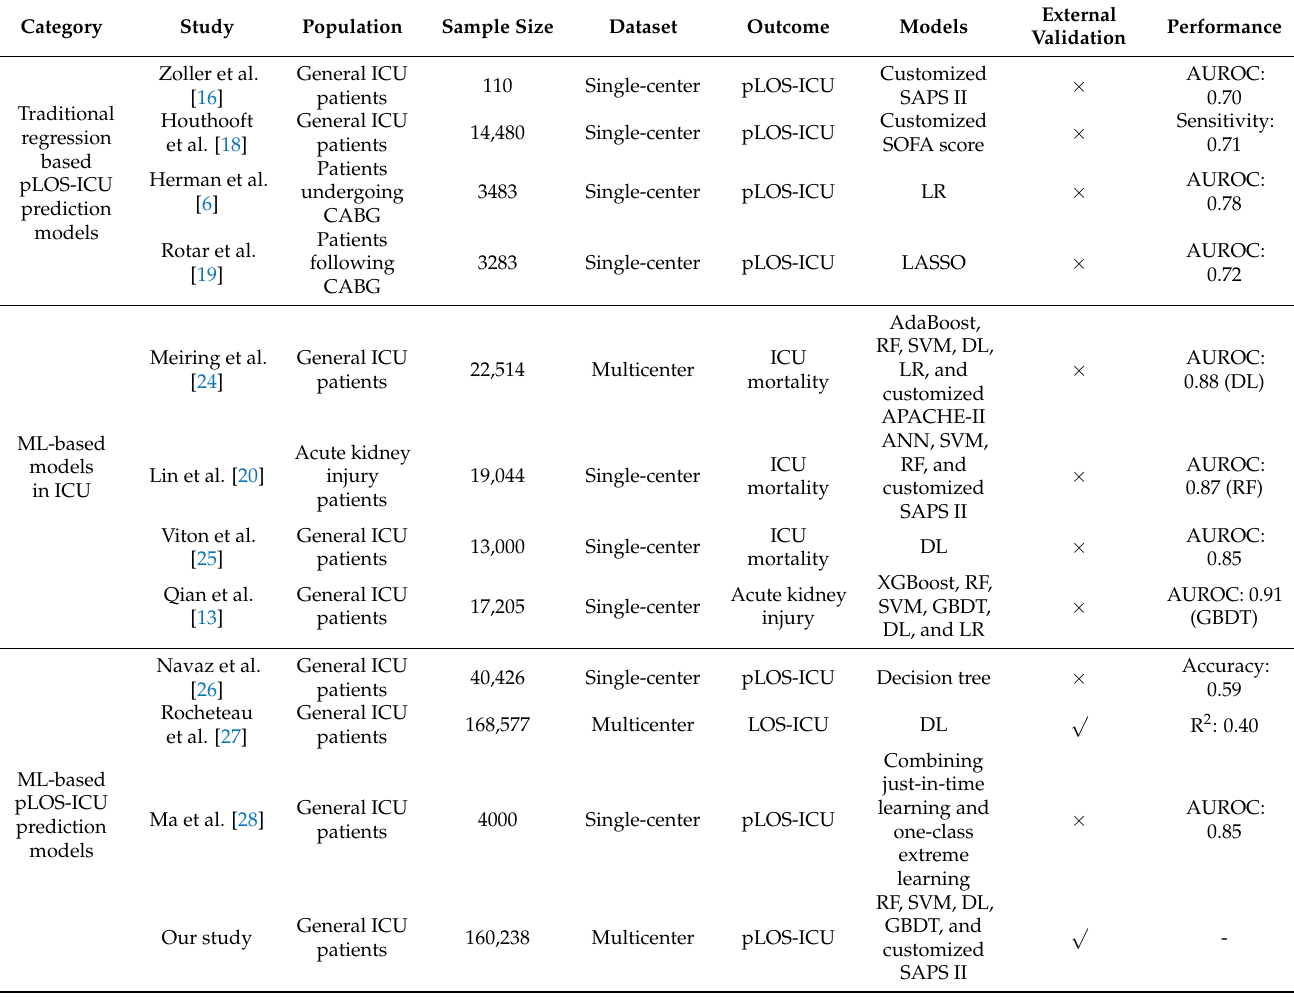
Table 1. Characteristics of related